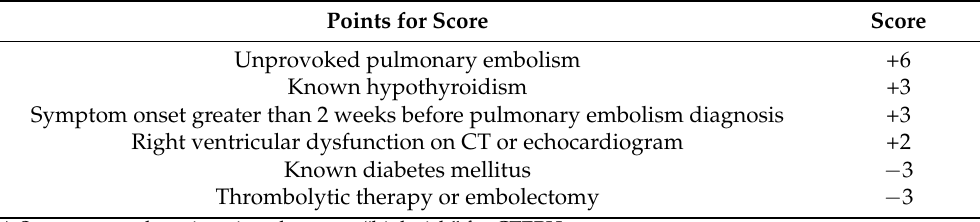
Table 1. CTEPH Prediction Score; a Score of More Than Six Points Denotes a high risk. Points for Score Score Unprovoked pulmonary embolism +6 Known hypothyroidism +3 Symptom onset greater than 2 weeks before pulmonary embolism diagnosis +3 Right ventricular dysfunction on CT or echocardiogram +2 Known diabetes mellitus − 3 Thrombolytic therapy or embolectomy − 3 A Score greater than six points denotes a “high risk” for